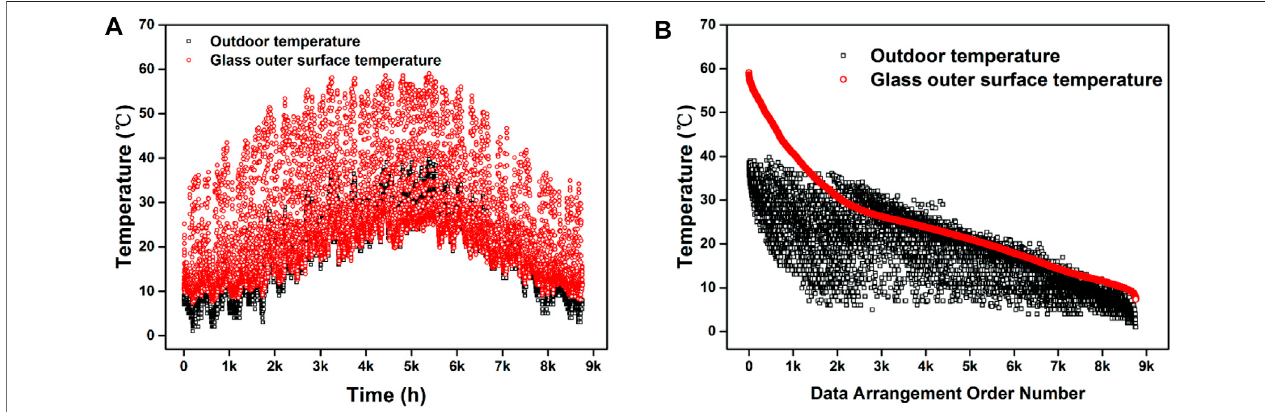
FIGURE3| Therawdataoftheoutdoorairtemperatureandtheoutersurfacetemperatureoftheglassfor8,760 h (A) andthedatasortedbythedescendingorder of the glass surface temperature (B) .